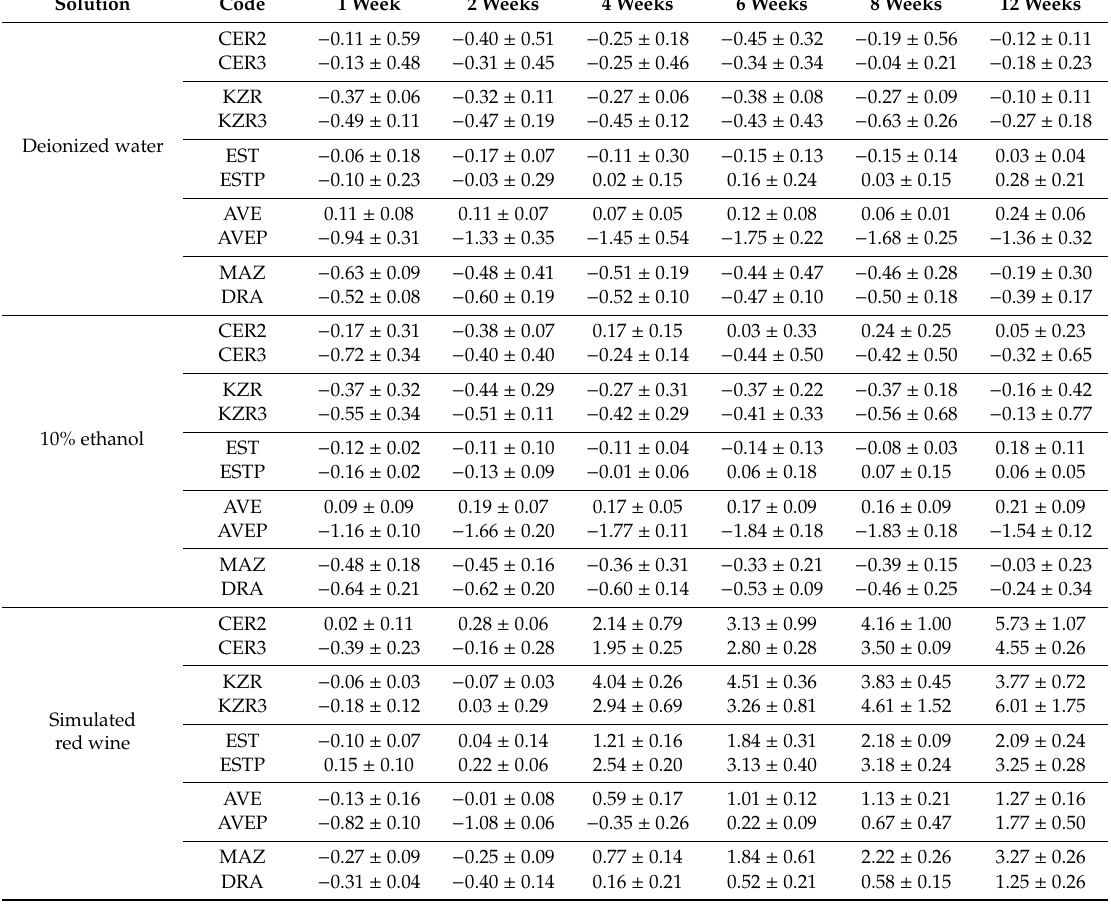
Table 3. Translucency parameter change ( ∆ TP) of samples as a function of immersion periods in 3 di ff erent